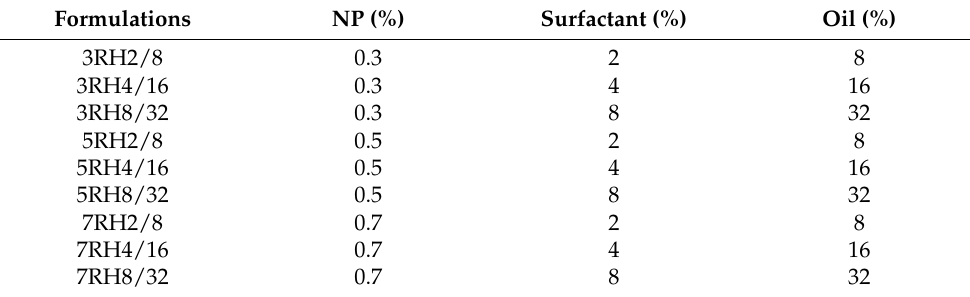
Table 1. Amounts of drug, surfactant, and oil in the emulsion formulations. Formulations NP (%) Surfactant (%) Oil (%) 3RH2/8